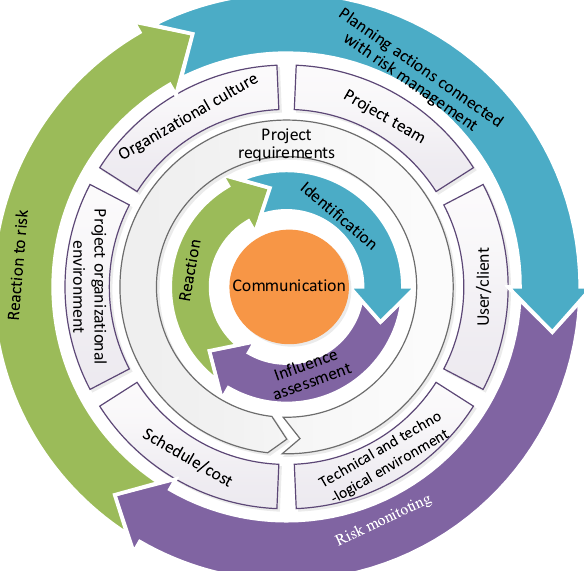
Figure 5. A model for risk management in IT projects.